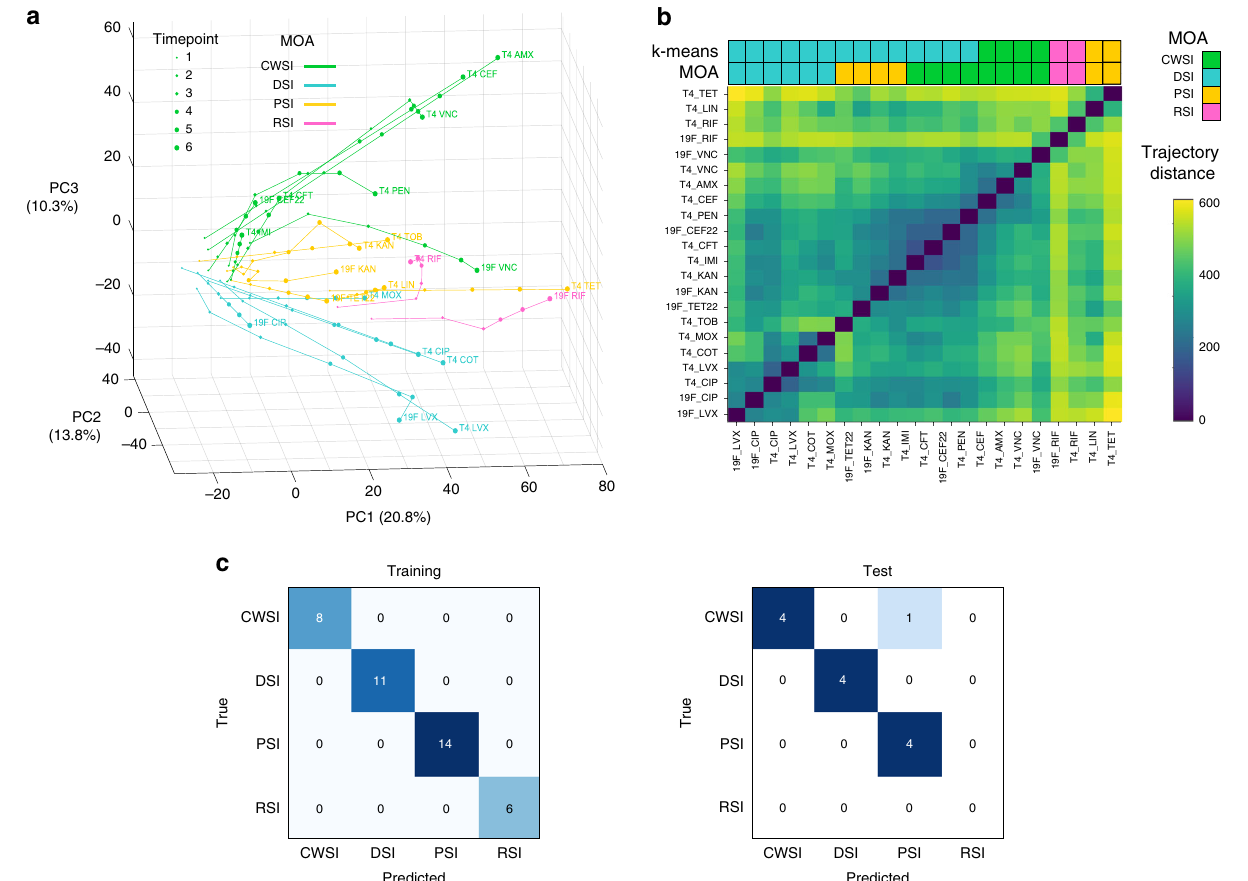
Fig. 2 Transcriptional responses separate antibiotics with different mechanisms of action. a Principal component analysis (PCA) on differential expression datasets from sensitive S. pneumoniae strains T4 and 19F grown in the presence of 16 different antibiotics at 1× MIC depicts antibiotic responses as temporal transcriptional trajectories. Each line describes the trajectory of one of one strain in the presence of a CWSI (AMX, CEF, CFT, IMI, PEN, VNC), DSI (CIP, COT, LVX, MOX) PSI (KAN, LIN, TET, TOB), or RSI (RIF). Trajectories for each strain are largely grouped based on their MOA, and grouped- trajectories become more distinct over time. The size of each data point increases with the time of antibiotic exposure; each trajectory is split into 6 timepoints, e.g., for an experiment that spans 120 ′ each point indicates a 20 ′ increment. Abbreviations are as in Fig. 1. b In order to quantify the separation of the PCA trajectories by an antibiotic ’ s MOA, pairwise distances between PCA trajectories were computed (see Methods). Pairs of transcriptional trajectories obtained using drugs within the same MOA tend to have smaller distances than pairs obtained using drugs with different MOA ’ s. K -means clustering of the trajectory distances groups the trajectories mostly by MOA, although some PSI and CWSI trajectories are grouped with DSI ones. The top and bottom bars above the heatmap show the K -means clustering result, and the real MOA of each trajectory respectively, which have 64% agreement. c Confusion matrices indicating the performance of the gene-panel that predicts MOA. This panel was generated using a multi-class regression model (see Supplementary Table 1 for the training and test set split, and Methods for details on parameter tuning) and consists of 34 genes. The gene-panel correctly predicts the MOA on all training set data and only misclassi fi es a single experiment on the previously unseen test dataset, showing the different MOA ’ s being easily distinguishable with simple gene-based